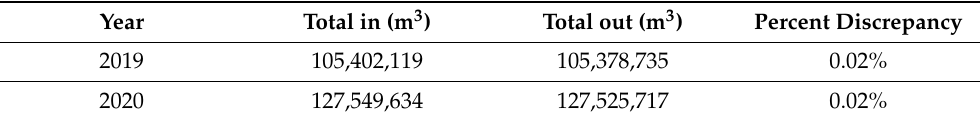
Table 8. Yearly water balance for transient groundwater modeling Scenario